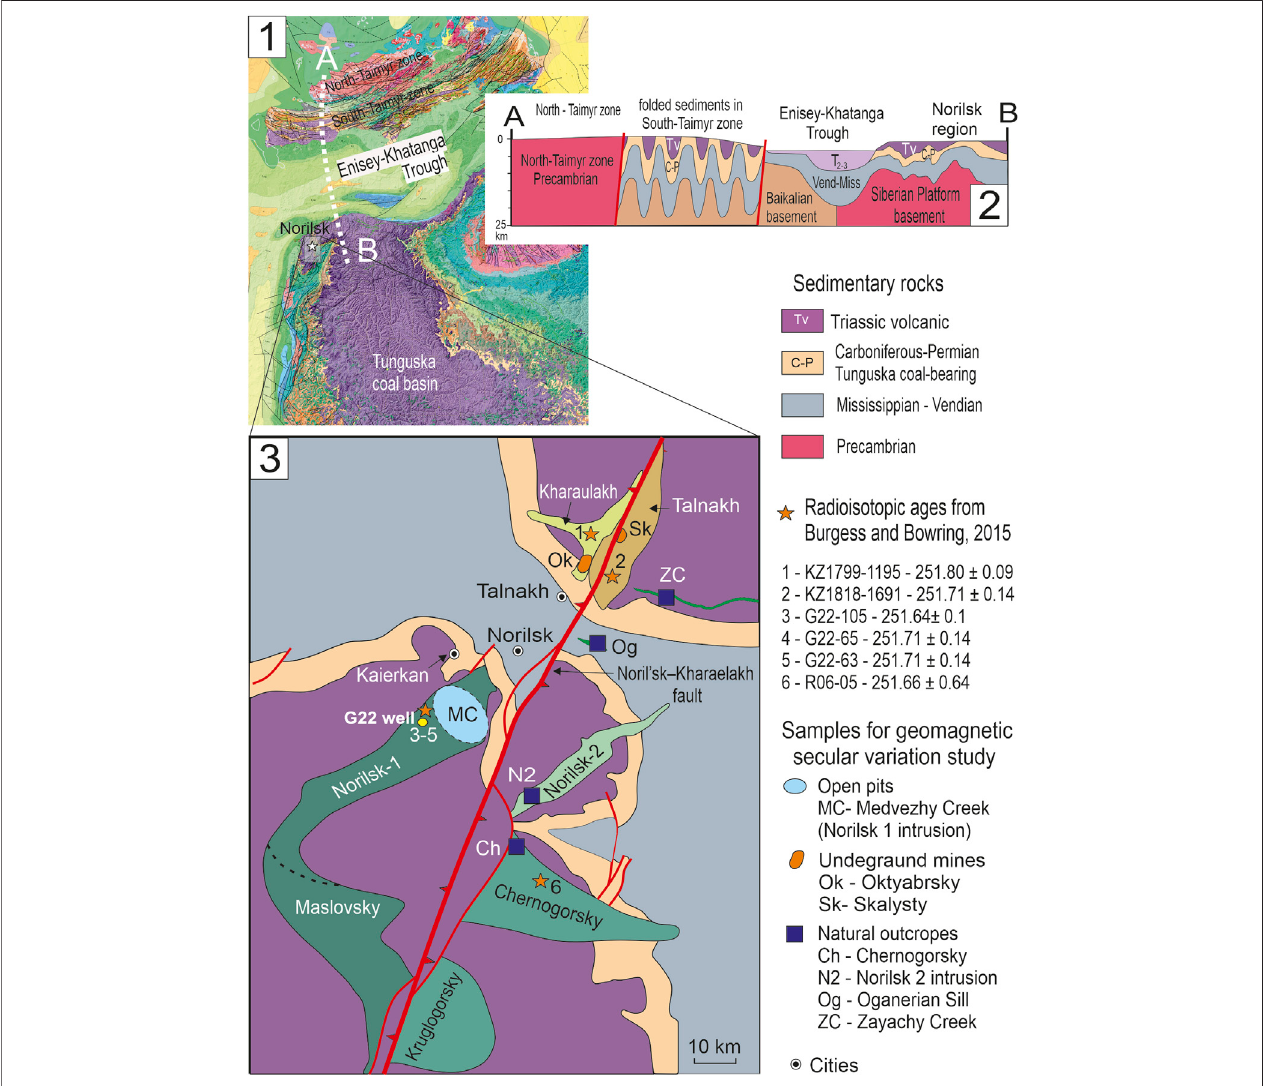
FIGURE 1 | Location and position of the Norilsk region within the geologic, stratigraphic and structural content. (1) - Geologic map of the north-western corner of Siberian Platform (from Petrov, 2016). (2) - Cross-section of the northern Siberian Platform along the line Dikson city (A) – Khantai lake (B) - white dashed line on Figure1A [modi fi edfromAfanasenkovetal.(2016)]; (3) -Simpli fi edgeologicmapofNorilskregionwithmainlayeredintrusions,fromwhichBurgessandBowring(2015) obtained the U-Pb ages [modi fi ed from Krivolutskaya (2016), Rad ’ ko (2016) Dark blue boxes - samples of Latyshev et al.,